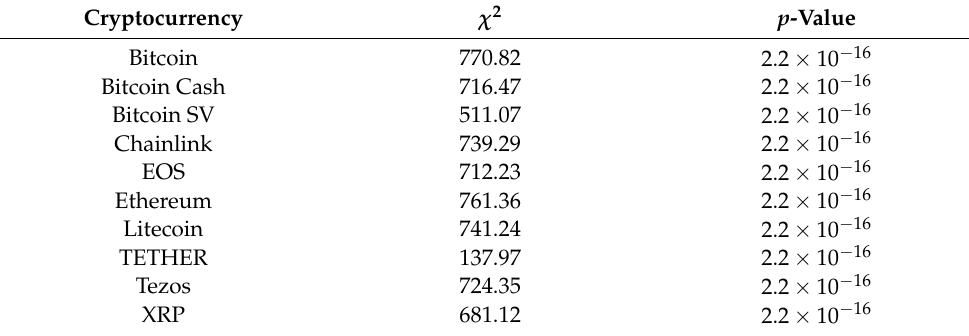
Table 4. ARCH-LM